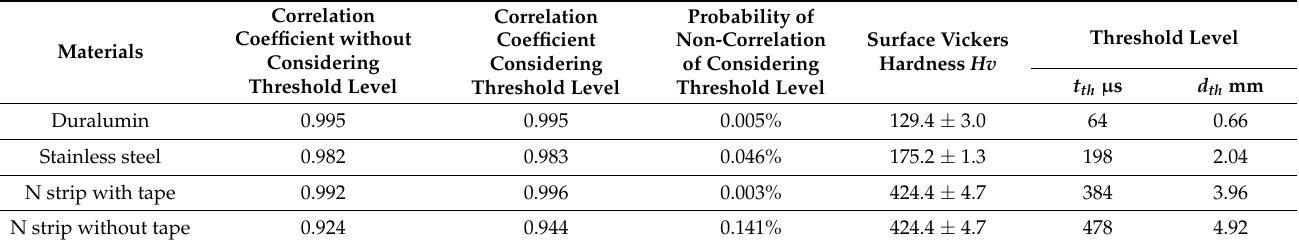
Figure 7. Relationship between the developing time of laser cavitation and the arc height. ( a ) The power law without considering the threshold level; ( b ) the power law considering the threshold level. Table 2. Relationship between surface Vickers hardness Hv and threshold